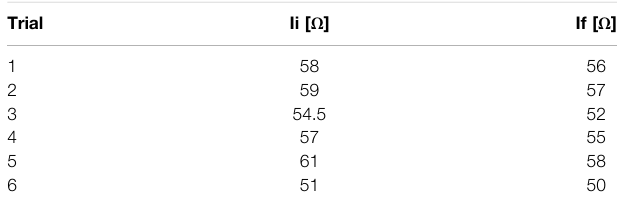
TABLE 1 | Impedance values at the starting (Ii) and ending (If) instants of each of the six experimental RF delivery process. Trial